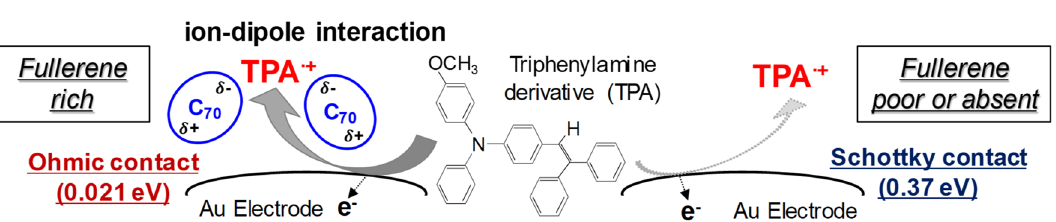
Figure 6. Schematic representation of the barrier height reduction mechanism with hole injection at the Au/ fullerene-doped TPA